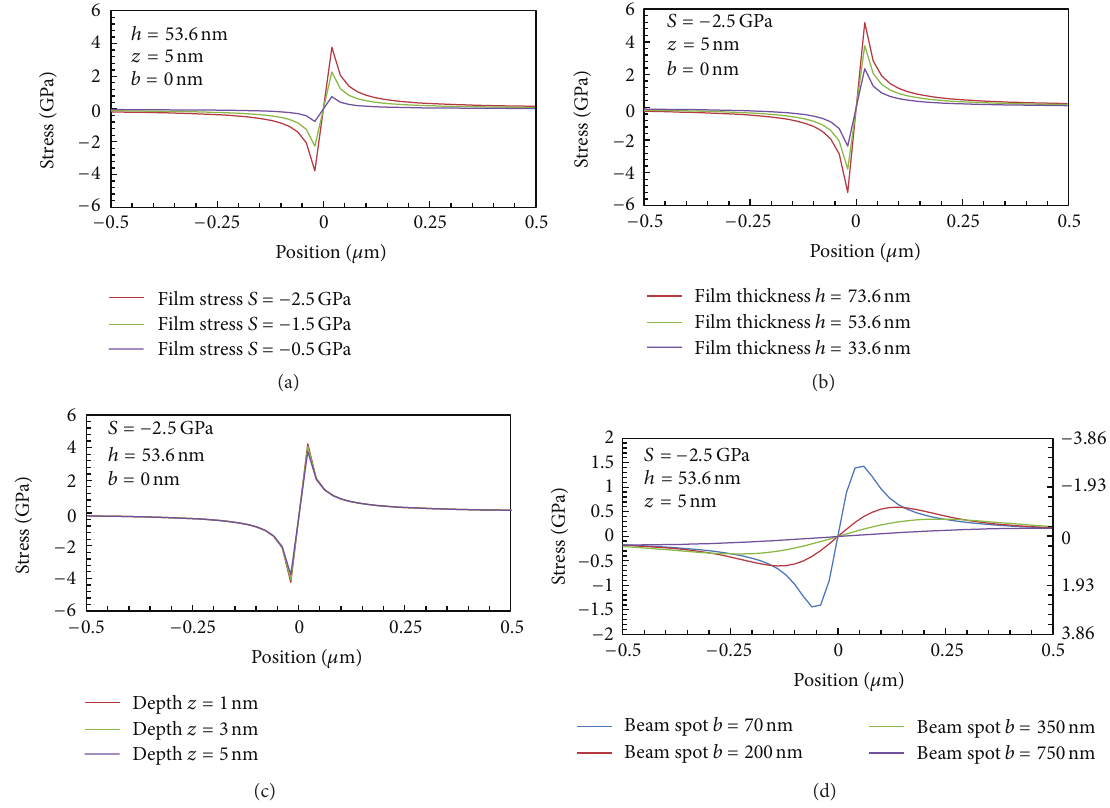
of the film stress, (b) ℎ of the film thickness, (c) 𝑧 of the detection depth, and (d) 𝑏 of the Film Film